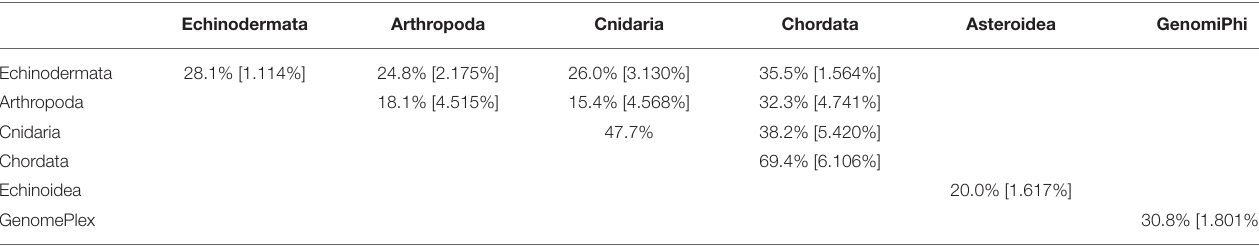
TABLE 3 | Pair-wise matrix of mean similarity and standard error (in brackets) of total viromes (i.e., including bacteriophage) within and between host phyla, between asteroids and echinoids, and between GenomePlex and GenomiPhi prepared libraries (from Pyura chilensis urochordate samples).